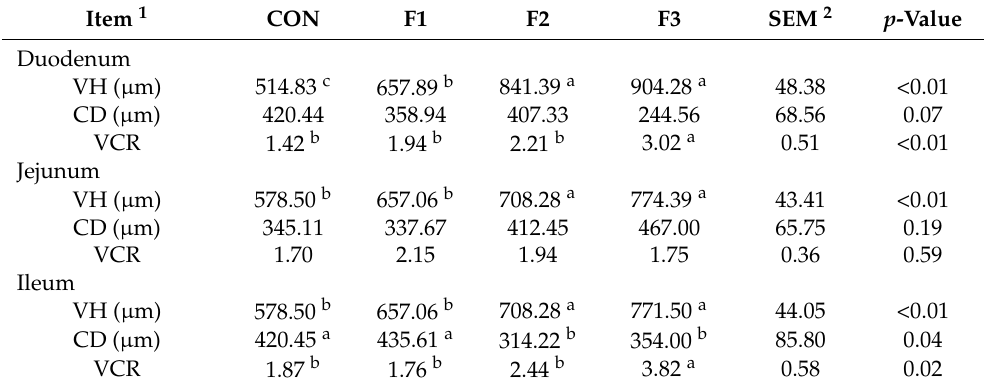
Table 4. Effects of dietary fucoidan administration on intestinal morphology in weaned